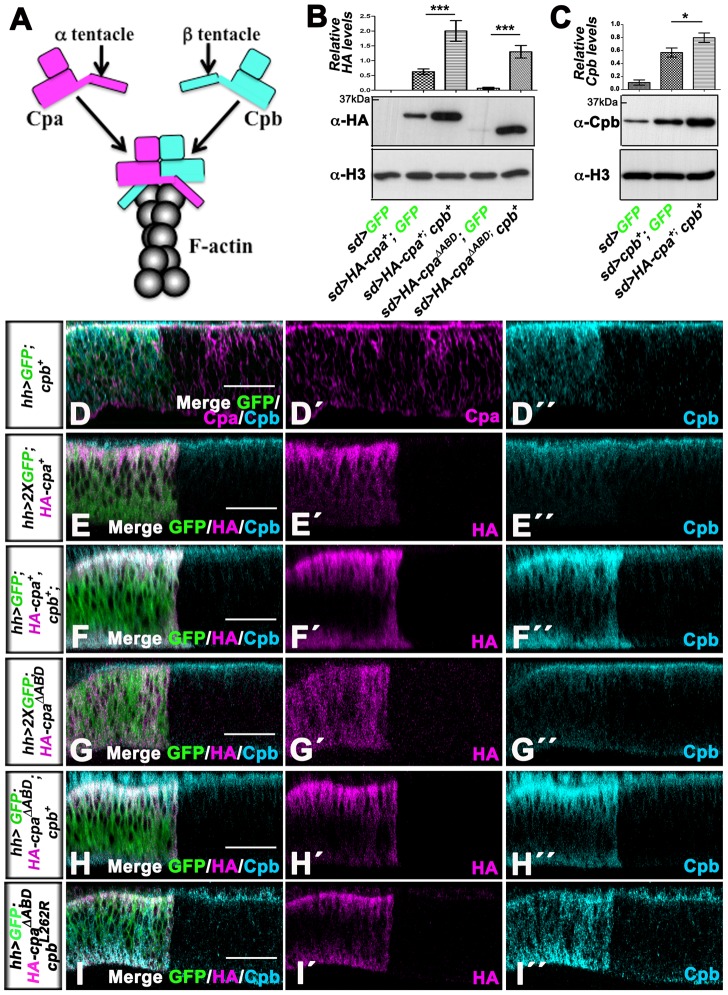
Increasing the levels of individual CP subunits alone has no effect on the endogenous levels of the other subunit, while co-expressing HA-cpa or HA-cpaΔABD and cpb enhance synergistically the levels of both subunits.(A) model by which Cpa and Cpb cap F-actin barbed ends via the interaction of α and β tentacles with actin. (B) western blot on protein extracts from wing discs expressing UAS-mCD8-GFP (lane 1) or UAS-mCD8-GFP and UAS-HA-cpa89E (lane 2) or UAS-HA-cpa89E and UAS-cpb7 (lane 3) or UAS-mCD8-GFP and UAS-HA-cpaΔABD (lane 4) or UAS-HA-cpaΔABD and UAS-cpb7 (lane 5) under sd-Gal4 control, blotted with anti-HA (middle panel) and anti-H3 (lower panel). The means for lane 1 is 0, for lane 2 is 0.6250, for lane 3 is 2, for lane 4 is 0.0667, for lane 5 is 1.300. Error bars indicate s.e.m.. P<0.0092 for comparison of lanes 2 and 3 and of lanes 4 and 5. (B) western blot on protein extracts from wing discs expressing UAS-mCD8-GFP (lane 1) or UAS-mCD8-GFP and UAS-cpb7 (lane 2) or UAS-cpb7 and UAS-HA-cpa89E (lane 3) under sd-Gal4 control, blotted with anti-Cpb (middle panel) and anti-H3 (lower panel). The upper panels in B and C represent a quantification of relative (B) HA or (C) Cpb intensity signals for each genetic combination, measured by 4 independent blots. The means for lane 1 is 0.1088, for lane 2 is 0.5699, for lane 3 is 0.7982. Error bars indicate s.e.m. P<0.0182 for comparison of lanes 2 and 3. (D–D″ to I–I″) optical cross sections through distal epithelia of third instar wing imaginal discs with apical sides up and posterior sides to the left in which hh-Gal4 drives (D–D″) UAS-cpb7 and one copy of UAS-mCD8-GFP (green in D) or (E–E″) UAS-HA-cpa89E and two copies of UAS-mCD8-GFP (green in E) or (F–F″) UAS-HA-cpa89E, UAS-cpb7 and one copy of UAS-mCD8-GFP (green in F) or (G–G″) UAS-HA-cpaΔABD and two copies of UAS-mCD8-GFP (green in G) or (H–H″) UAS-HA-cpaΔABD, UAS-cpb7 and one copy of UAS-mCD8-GFP (green in H) or (I–I″) UAS-cpbL262R, UAS-HA-cpaΔABD and one copy of UAS-mCD8-GFP (green in I). Discs are stained with anti-Cpb (Cyan blue) and (D–D″) anti-Cpa (magenta) or (E–E″ to I–I″) anti-HA (magenta), which reveals (E–E″ and F–F″) HA-cpa89E or (G–G″ to I–I″) HA-cpaΔABD expression. The scale bars represent 15 µm.